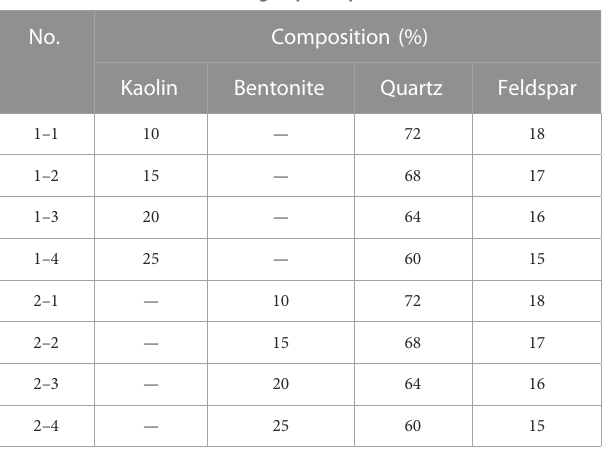
TABLE 2 Information on these four soil minerals.